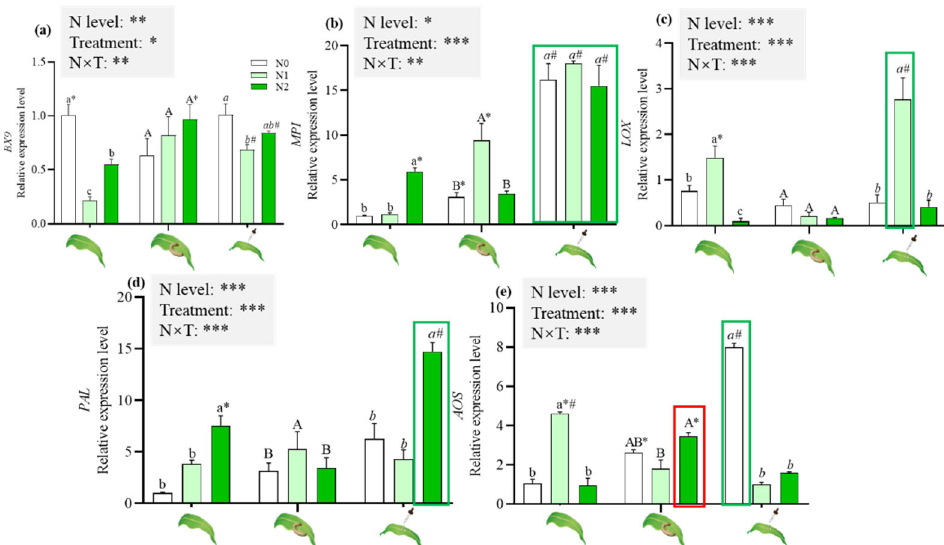
Figure 6. Effects of N supply on the genes involved in the induced defense of maize under different induced treatments. The red box shows a significantly higher AOS expression in S. frugiperda attacked maize than in JA treated maize. The green box shows a significantly higher gene expression in JA treated maize than in S. frugiperda attacked maize. GLM results of testing for N level and induced treatment effects are shown (n.s., not significant; * p < 0.05; ** p < 0.01; *** p < 0.001); different lowercase, uppercase and italic lowercase letters above the bars indicate significant differences among different N levels under the same induced treatments. The asterisk “*” above the bars indicates significant differences between maize with and without S. frugiperda attack; “#” above the bars indicates significant differences between maize with and without JA application. Abbreviations in the figure indicate the following: BX9 (glucosyltransferase); MPI (maize proteinase inhibitor); LOX (lipoxygenase); PAL (phenylalanine ammonia-lyase); and AOS (allene oxide synthase). The same abbreviations apply